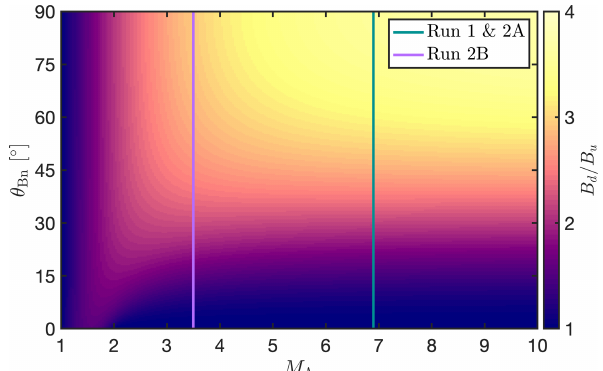
Figure 2. Downstream to upstream ratio of the magnetic field strength as a function of the Alfvén Mach number M A and the θ Bn angle between the IMF direction and the shock normal, calculated based on the Rankine–Hugoniot